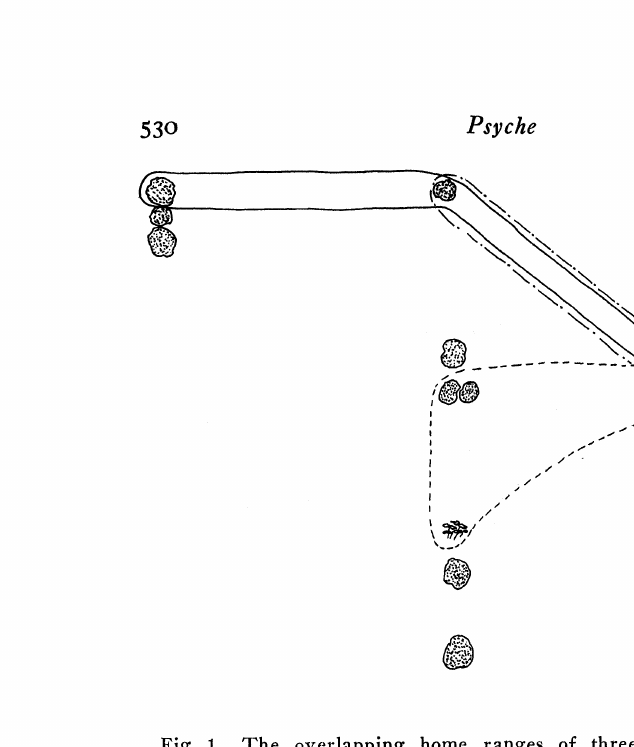
Fig. 1. The overlapping home ranges of three males at the orchard study area. "Blue’s" home range is outlined with a dashed llne; "red’s" home range is outlined with a dot-dashed line; "white-dot’s" home range .s outlined ith a solid lne. The circular stippled areas represent prominent Salsola bushes. One large flowering weed is shown schematically in the lower left hand corner of "blue’s" home